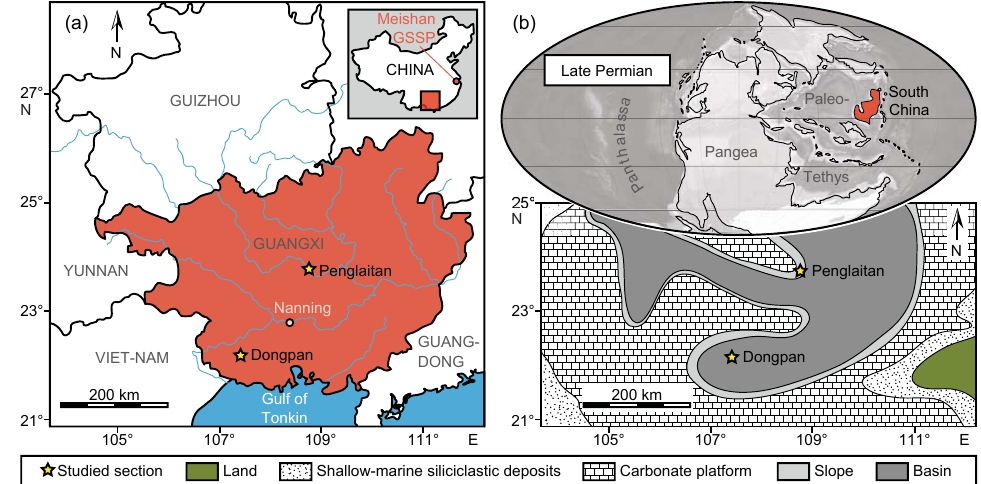
Figure 1. (a) Locality map showing the position of Dongpan, Penglaitan and Meishan Global Stratotype Section and Point (GSSP), China. (b) Late Permian paleogeographic reconstruction after Ziegler et al. (1997), indicating the location of the South China block in the peri- Gondwana region. Beneath the paleogeographic map of the Nanpanjiang Basin in South China showing the position of the investigated Dongpan and Penglaitan section during late Permian times (base map modified after Wang and Jin,